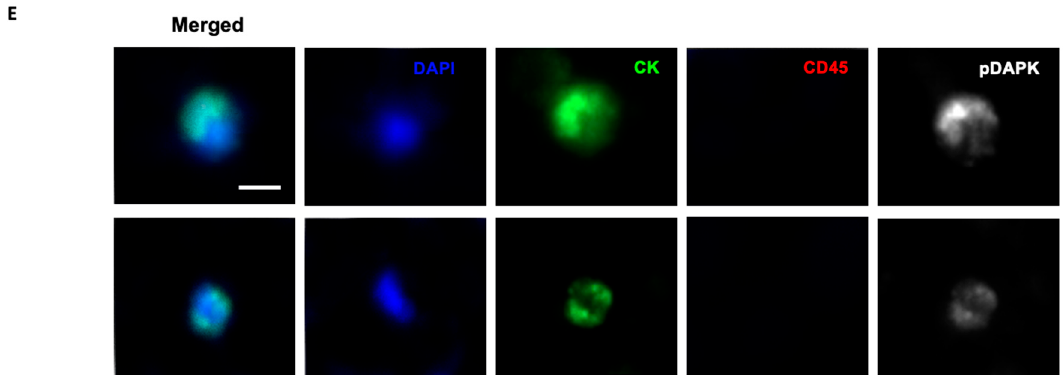
Figure 1. ( A ) Waterfall diagram showing changes in tumor size in target lesions in eight patients who achieved SD. ( B ) Treatment duration of each patient. ( C ) Overall survival of the patients. ( D ) Correlation of proportion of pDAPK + CTC numbers with treatment duration. ( E ) Immunofluorescence staining of representative circulating tumor cells obtained from patients. Cancer cells fulfilled criteria for CTCs, including: CK − positive (green), CD45 − negative cells (non-red), and nucleated (blue). Scale bar = 5 μ m.